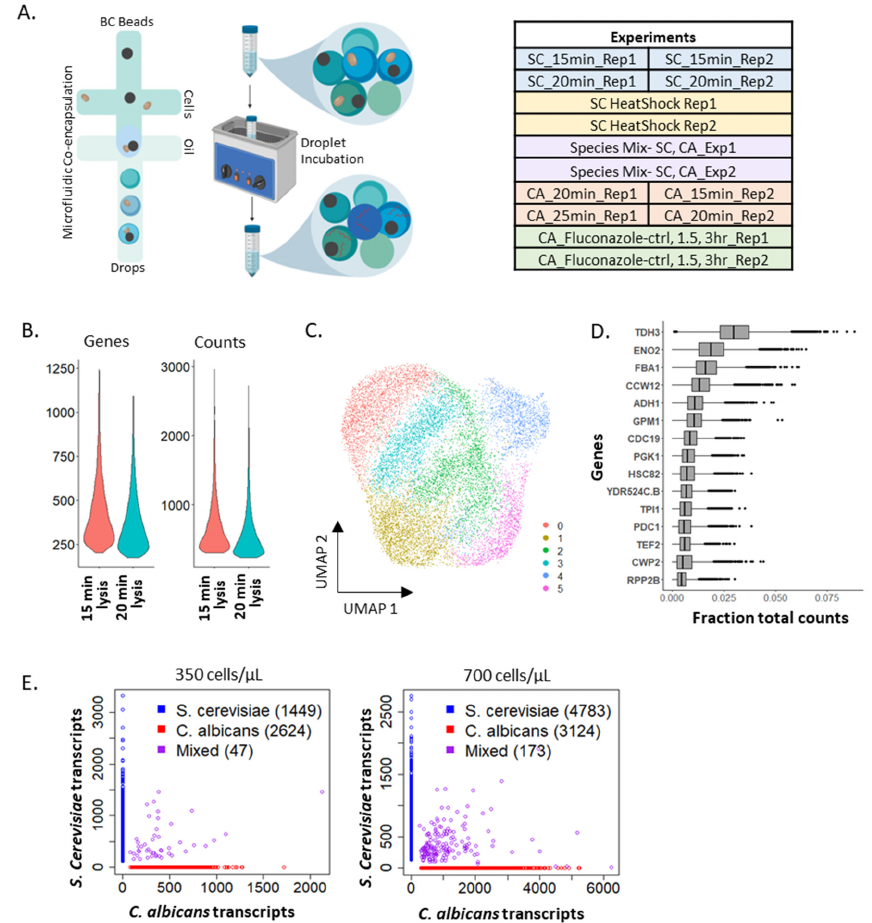
Figure 1. mDrop-seq of Saccharomyces cerevisiae cells. ( A ) mDrop-seq experimental schematic (left) and list of mDrop-seq experiments on different yeast samples (right). ( B ) Number of genes and UMI detected for each cell at two cell lysis times: 15 and 20 min. ( C ) UMAP visualizing the clustering on 12,012 S. cerevisiae cells. ( D ) Boxplot displaying the top 15 genes expressed by fraction of total counts for 15 and 20 min lysis times. ( E ) Species-mixing plots where each dot depicts a unique cellular barcode that align to S. cerevisiae (blue), C. albicans (red), or both genomes (purple). Two Poisson loading concentrations of 350 cells/µL (left; λ = 0.08) and 700 cells/µL (right; λ = 0.15) were tested. ( A ) was generated using BioRender.com. To determine the duration of droplet incubation for optimal zymolyase activity needed for each species, a single collection of mDrop-seq droplets on S. cerevisiae was split